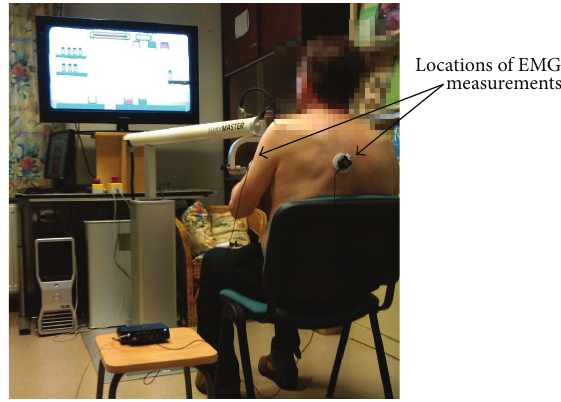
Figure 1: Experimental apparatus and